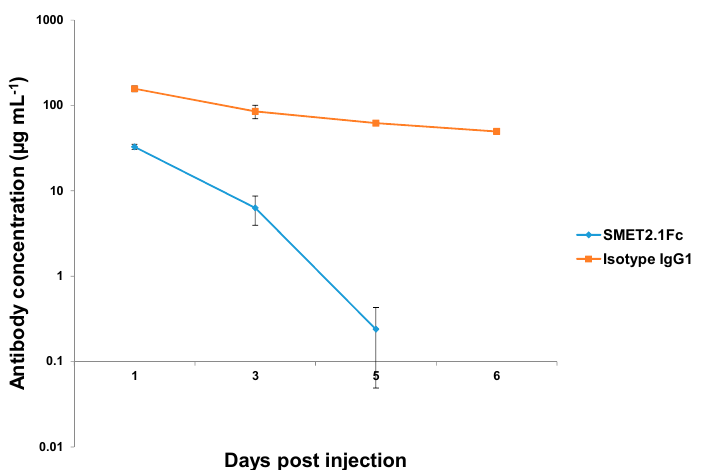
Figure 6. Pharmacokinetics of purified SMET2.1Fc monomer and an isotype IgG1 in NOD/SCID mice. Animals were intravenously injected with 0.5 mg antibody on day 0. Plasma was collected on days 1, 3, 5, and 6. Serum concentrations of antibodies were measured by ELISA. Each group included two animals. Plotted data are the mean ± standard deviation.